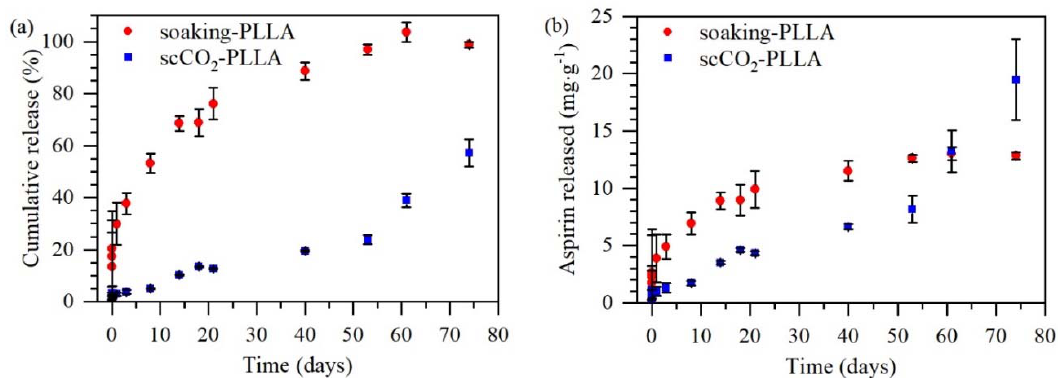
Figure 10. Comparison of the release profile of aspirin from soaking-PLLA and scCO 2 -PLLA samples, ( a ) cumulative release and ( b ) quantity of aspirin released. Table 5. Release kinetic parameters obtained from the Korsmeyer–Peppas model for soaking- PLLA and scCO 2 -PLLA.